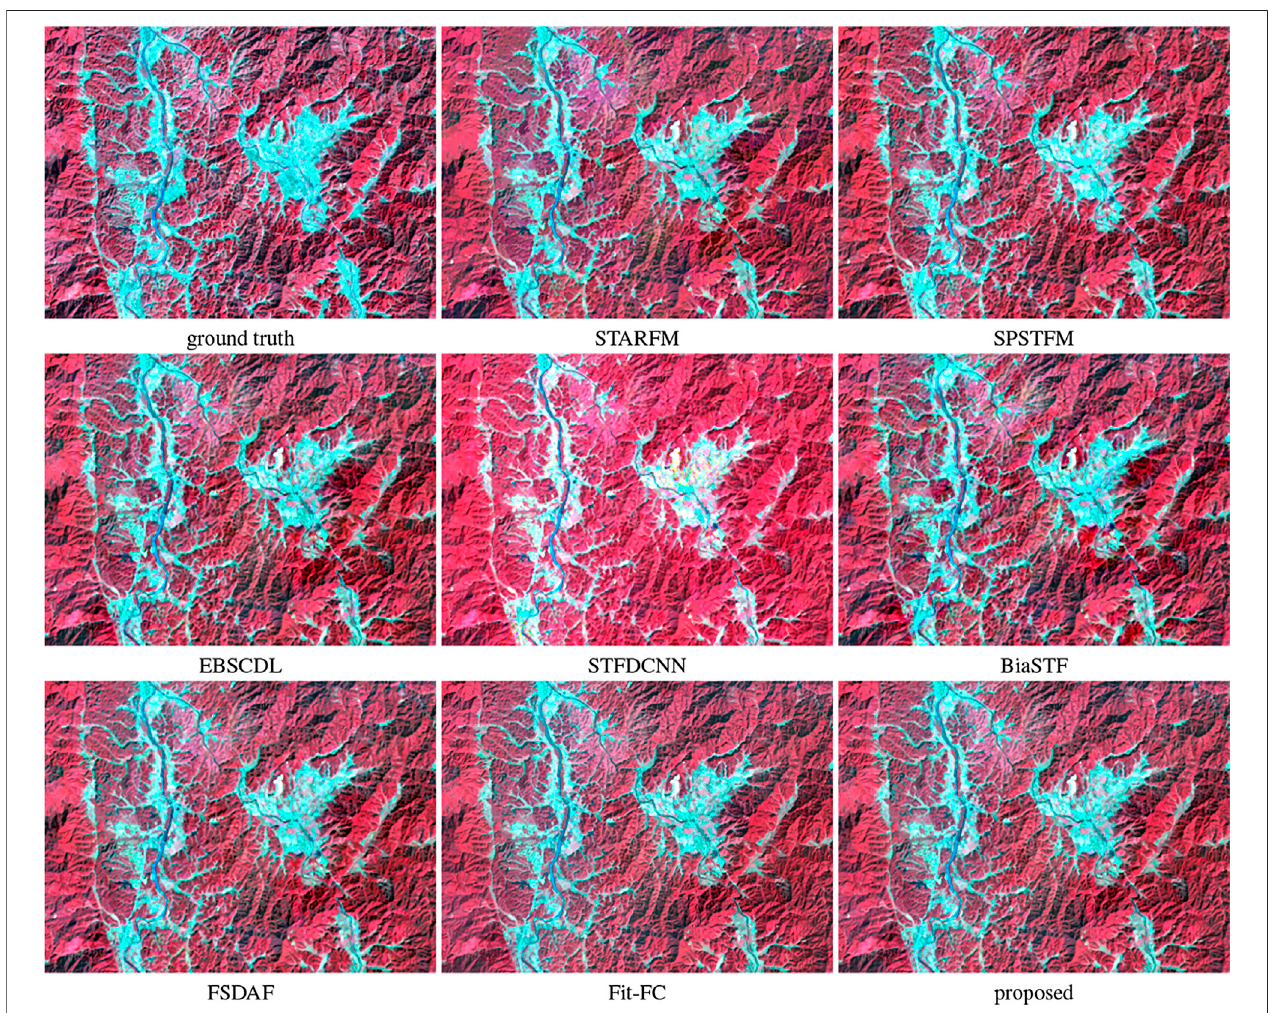
FIGURE 5 | Manifestation of the small region of the NIR, red, and green bands of Landsat-8 image 1 for detail observation.